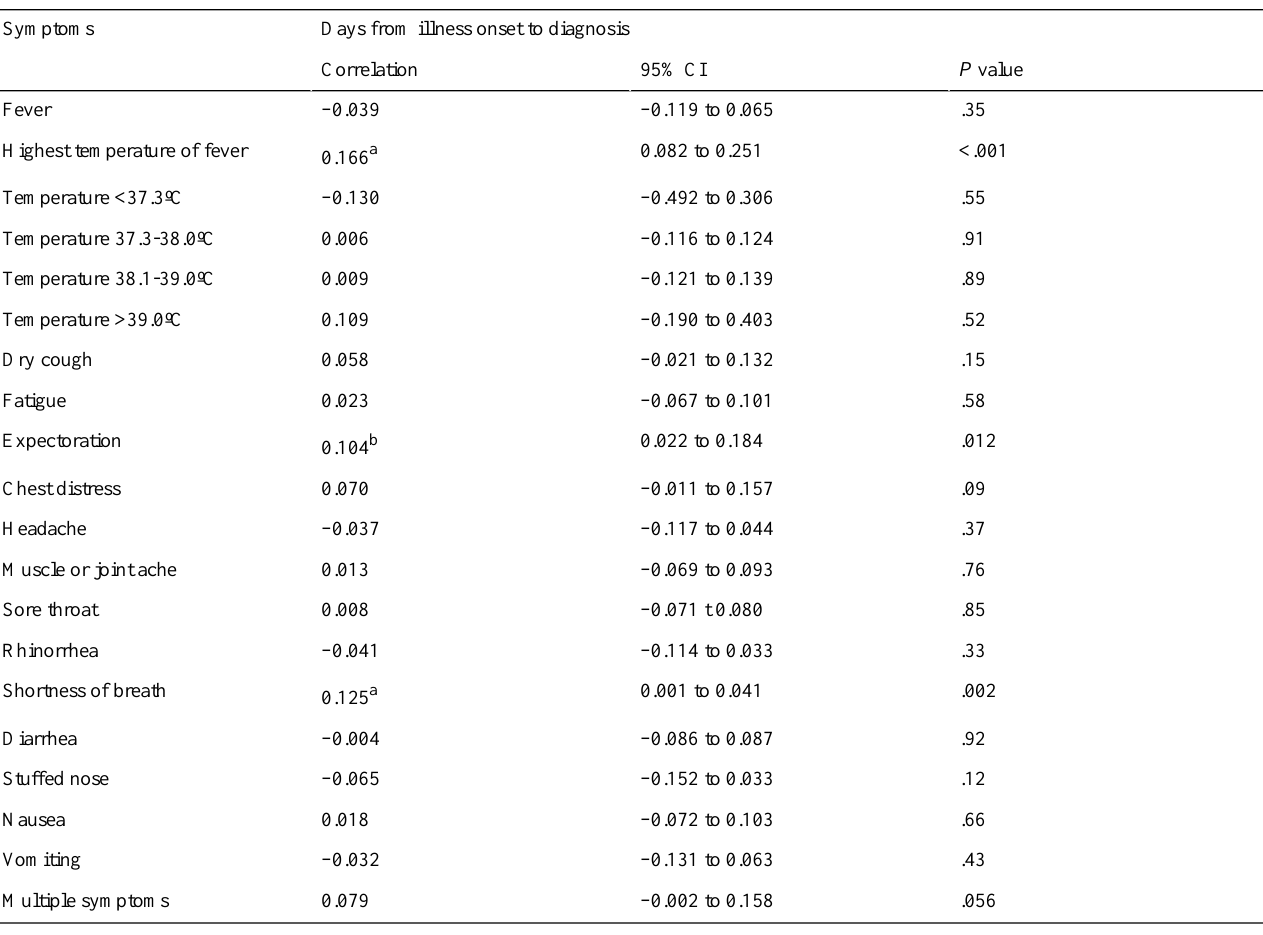
Table 4. Spearman correlation analysis of symptoms and days from illness onset to